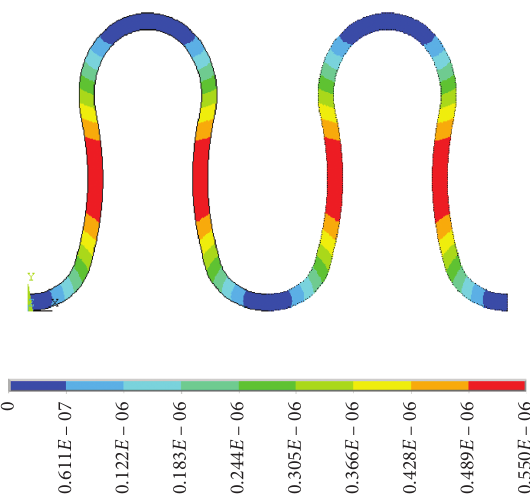
Figure 7: Deformation distribution at air inlet and gas outlet side without considering thermal stress (m).